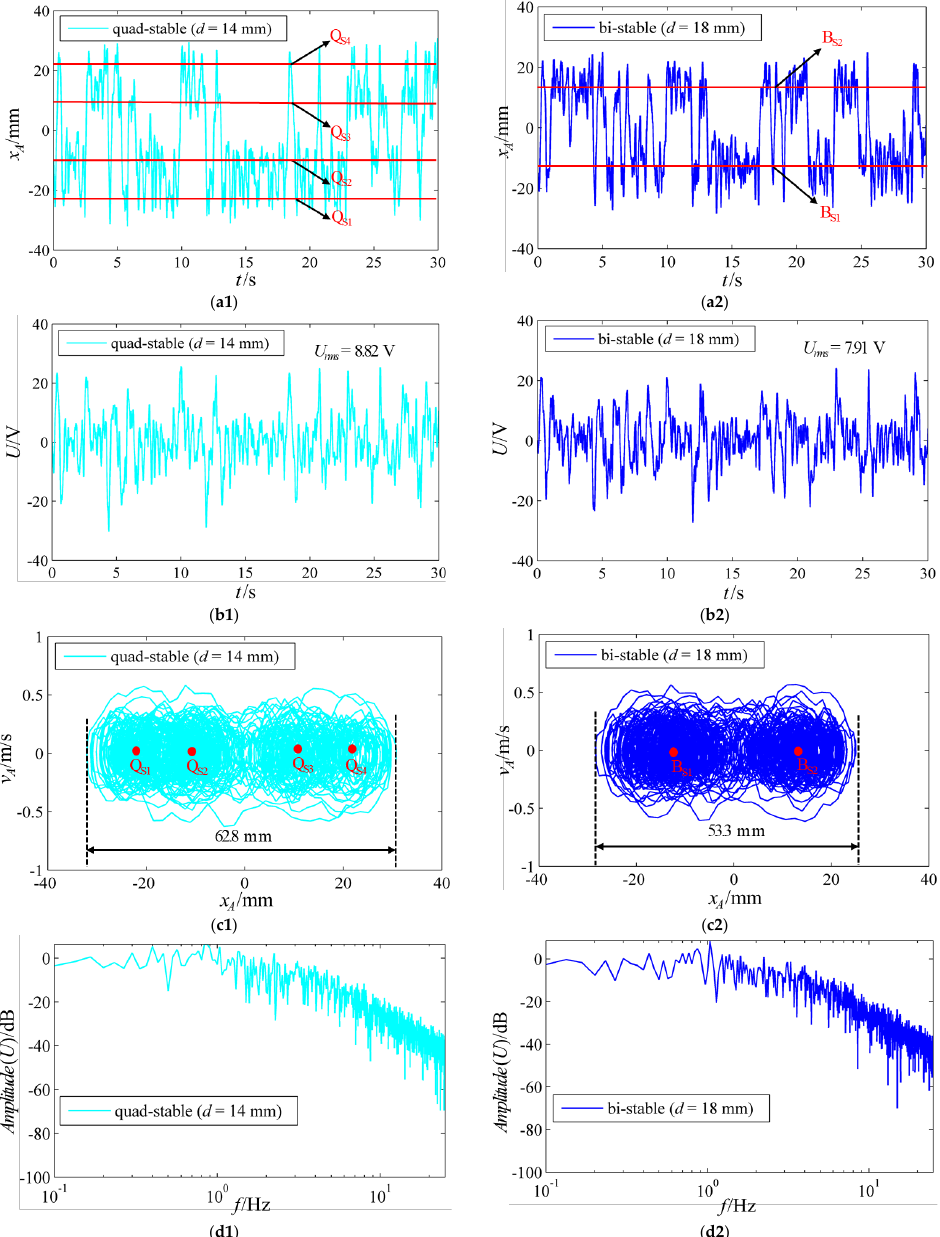
Figure 5. The ( a1 ) output displacement, ( b1 ) open circuit voltage, ( c1 ) phase portrait, and ( d1 ) PSD of the voltage under the quad-stable structural parameters when a Arms = 1.6 g; the ( a2 ) output displacement, ( b2 ) open circuit voltage, ( c2 ) phase portrait, and ( d2) PSD of the voltage under the bi-stable structural parameters when a Arms = 1.6